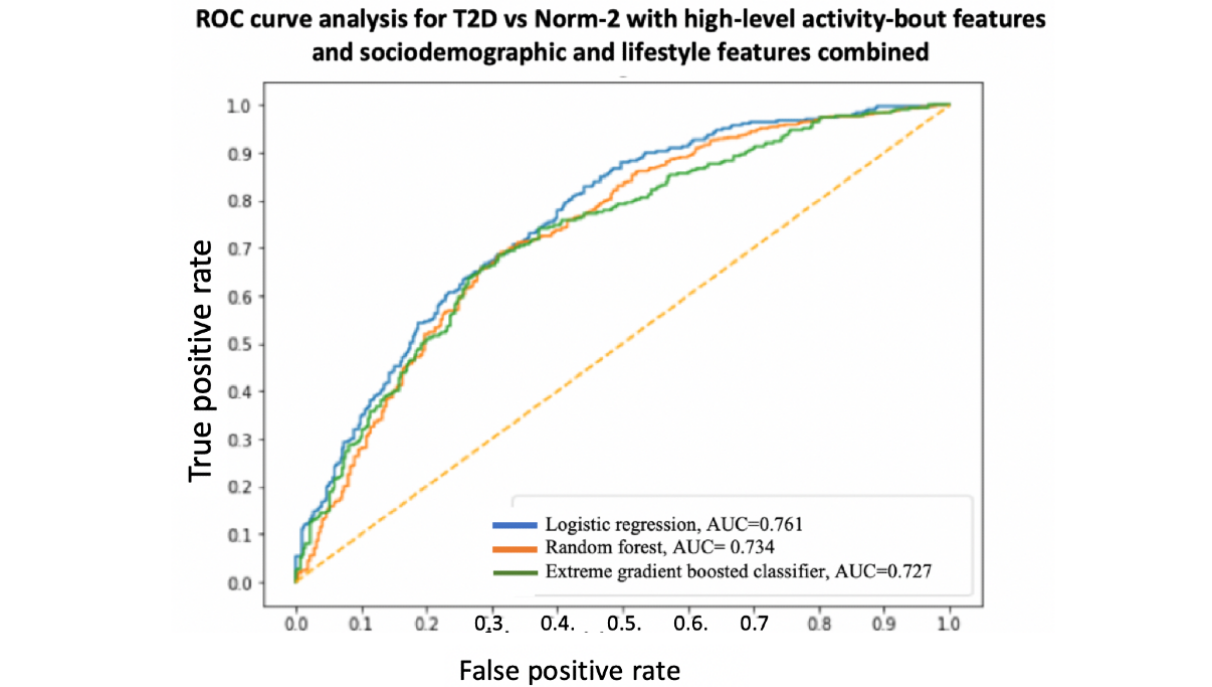
Figure 10. Receiver operating characteristic curve and area under the receiver operating characteristic curve for type 2 diabetes vs Norm-2: High-level activity bout features & sociodemographic and lifestyle features combined. AUC: area under the receiver operating characteristic curve; ROC: receiver operating characteristic curve; T2D: type 2